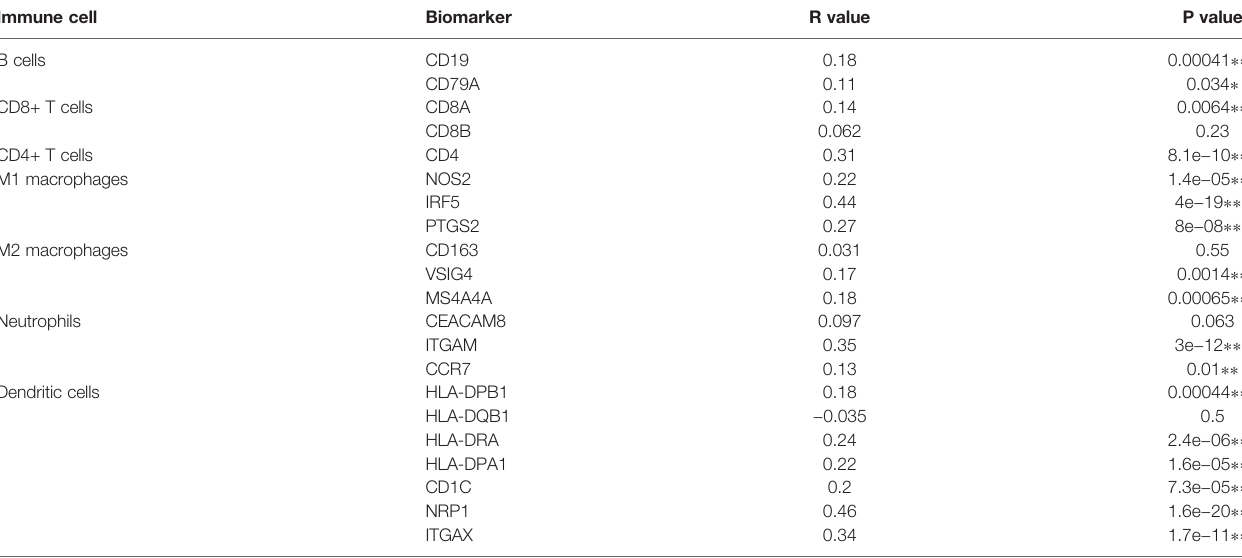
TABLE 2 | Correlation analysis of COMMD2 with immune cell biomarkers in LIHC. Immune cell